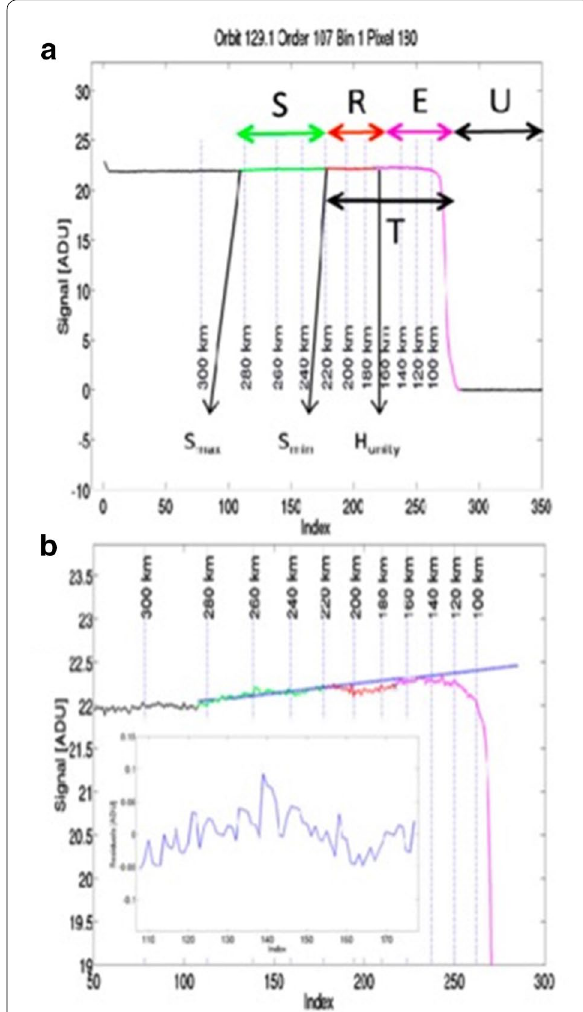
Fig. 9 (A) Separation of the Sun region into different zones for one detector pixel as a function of the index, i.e., the time after the beginning of the measurement. Lines corresponding to specific tangent altitudes are plotted. (B) Plot of the fit over the S region and extrapolation in the T region. The graph inside shows the residuals of the fit (taken from Trompet et al.